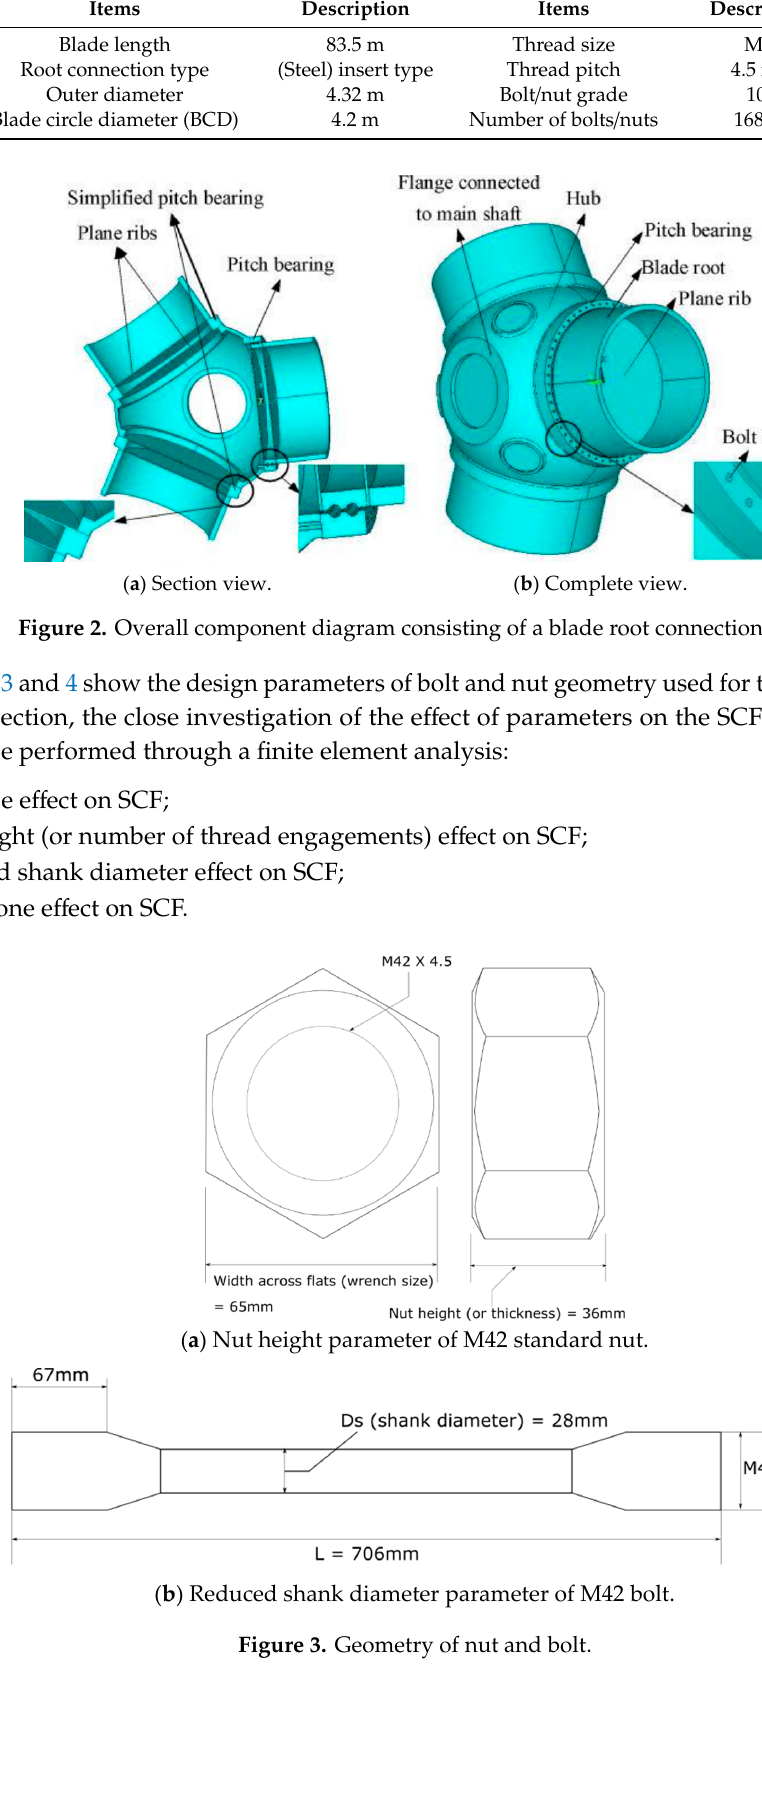
( d ) Bolt–nut joint model. Figure 5. Schematic diagram of a blade root joint model.